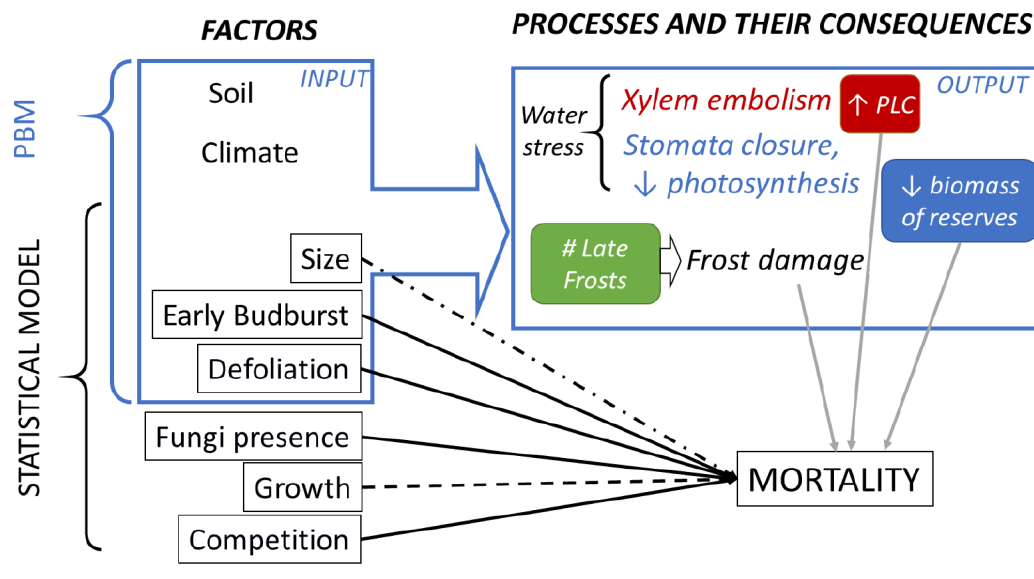
Figure 1. Combining process-based and statistical models to study variables and processes involved in tree mortality. The square boxes indicate the measured factors and response variables considered in statistical models. Boxes with rounded corners indicate stress-related output variables simulated with the PBM CASTANEA. The blue box on the left delineates the input variables of CASTANEA. At the top, grey arrows indicate the relationships considered to link stress-related output variables simulated by CASTANEA with observed mortality rate in the studied population . At the bottom, the black arrows indicate the relationships considered in the statistical model for the probability of mortality at individual level (solid lines: expected positive effect; dashed lines: expected negative effect; non-linear effects were expected for size). Moreover, the effects of size, early budburst and defoliation on the individual probability of mortality were also investigated using the PBM. PLC – percent loss of